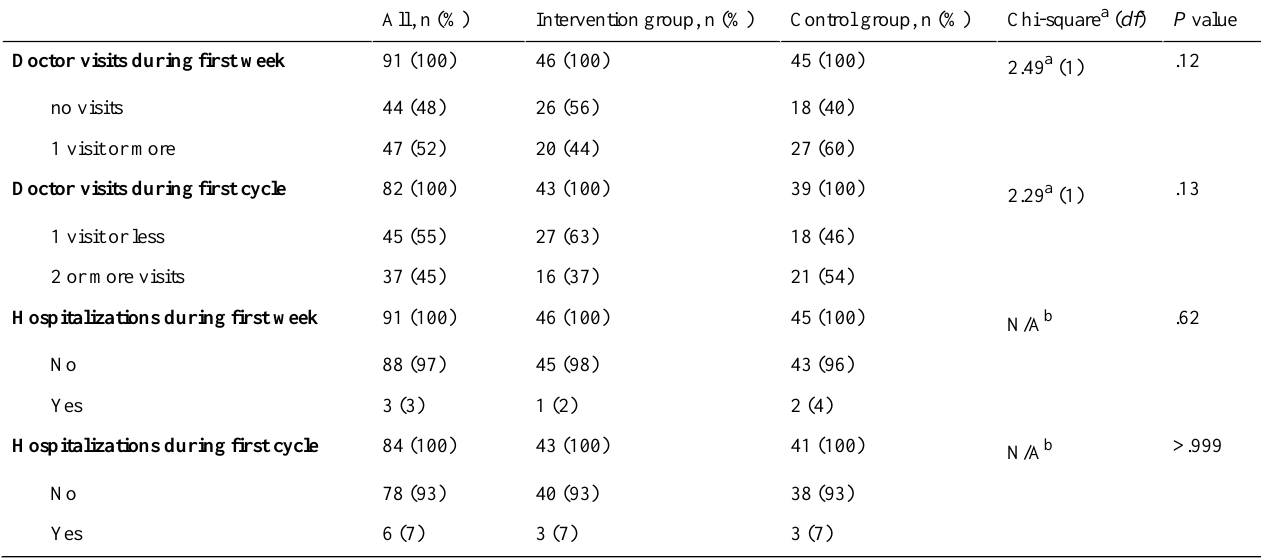
Table 4. Health care use during the first week and the first cycle of systemic